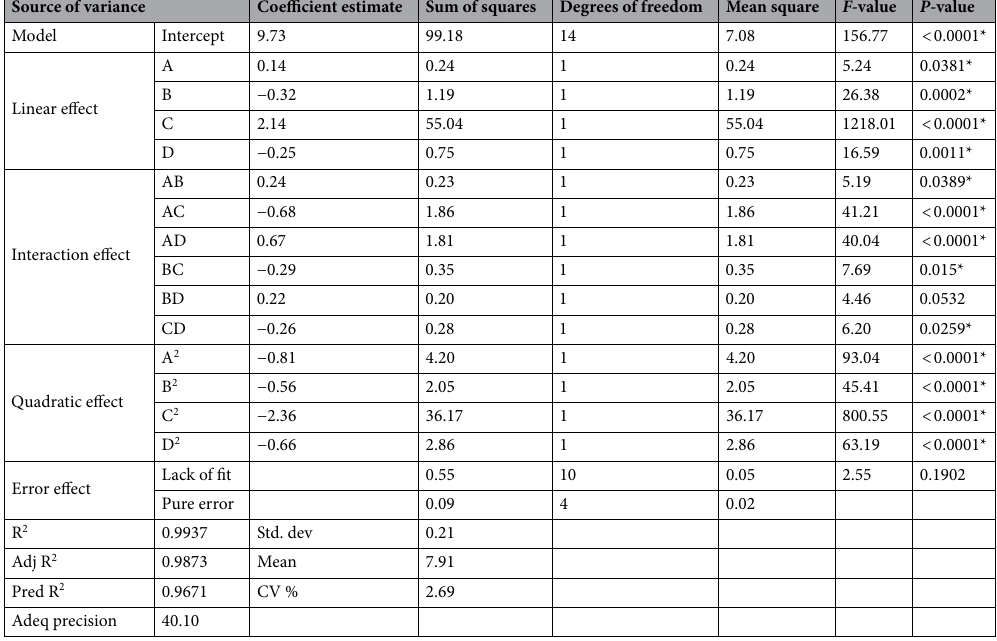
Table 2. Analysis of variance for chitosan nanoparticles biosynthesis using Eucalyptus globulus Labill leaves extract as affected by initial pH level, incubation period (min), chitosan concentration (%) and temperature (°C). F Fishers’s function, P level of significance, CV coefficient of variation. *Significant values.